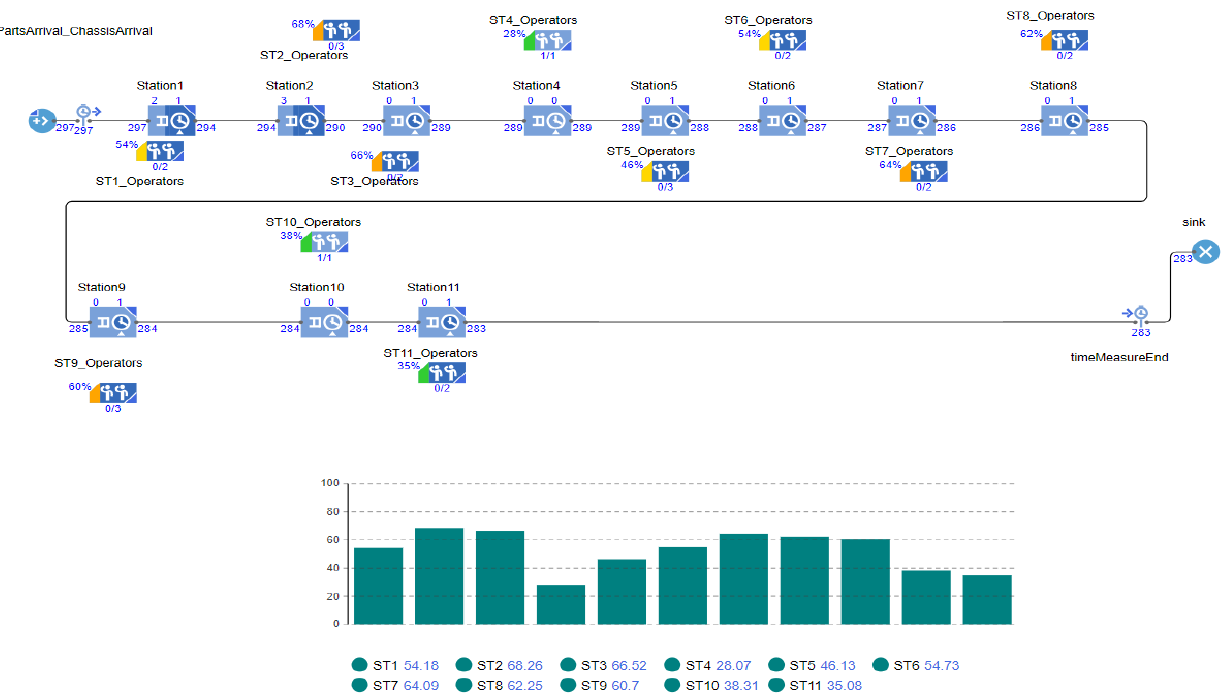
Figure 7. Balanced production system using DES.